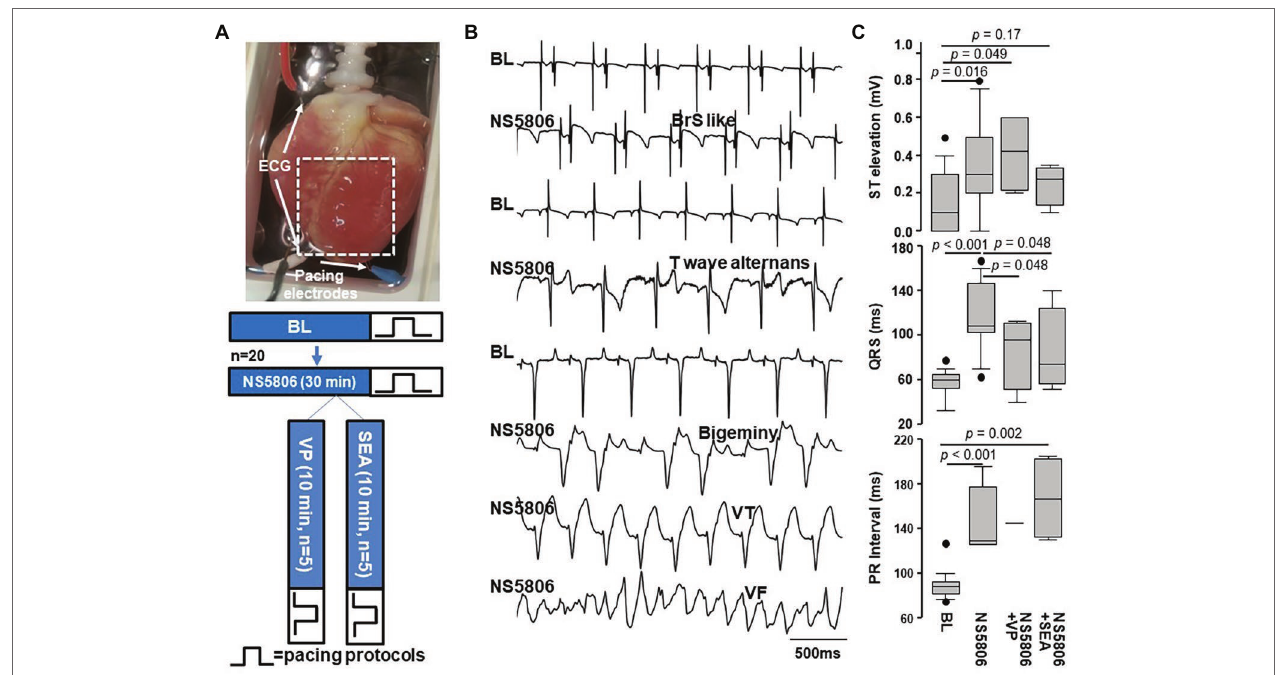
FIGURE 1 | Experimental protocol and representative examples of ECG changes induced by NS5806. (A) Langendorff-perfused rabbit hearts with ECG and pacing electrodes ( top ) and experimental protocol ( bottom ). Hearts were perfused with Tyrode’s solution. After stabilization and BL recording, hearts were perfused with NS5806 first. Additional drug studies followed: VP and SEA. (B) Representative examples of ECG changes induced by NS5806: BrS-like ECG features, bigeminy, T-wave alternans, VT and VF episodes. All were non-sustained. VF episodes were only observed with pacing. (C) ST segment elevation, QRS duration, and PR interval in different conditions. NS5806 induced QRS widening, ST-segment elevation, and PR prolongation. NS5806 + SEA prolonged PR interval. NS5806 + VP increased ST elevation. Box = 25th and 75th percentiles. Bars = minimum and maximum values. Dots = outliers. p < 0.05 was considered statistically significant. BL, Baseline; VP, Verapamil; SEA,